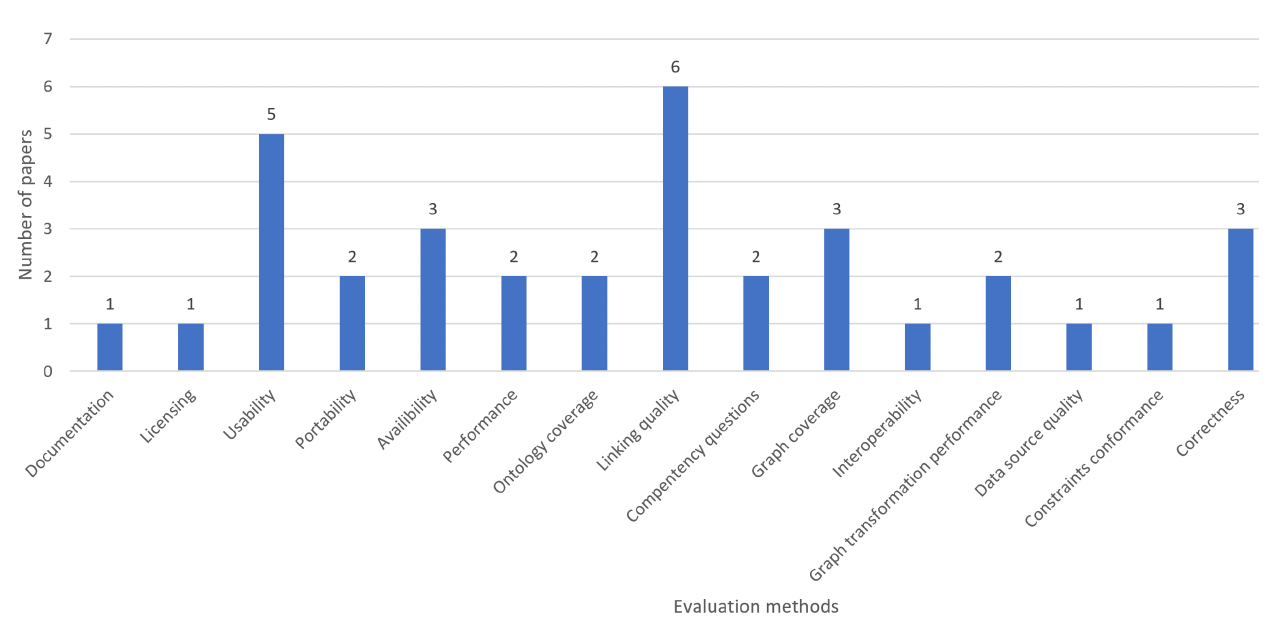
Figure 6. Evaluation methods.